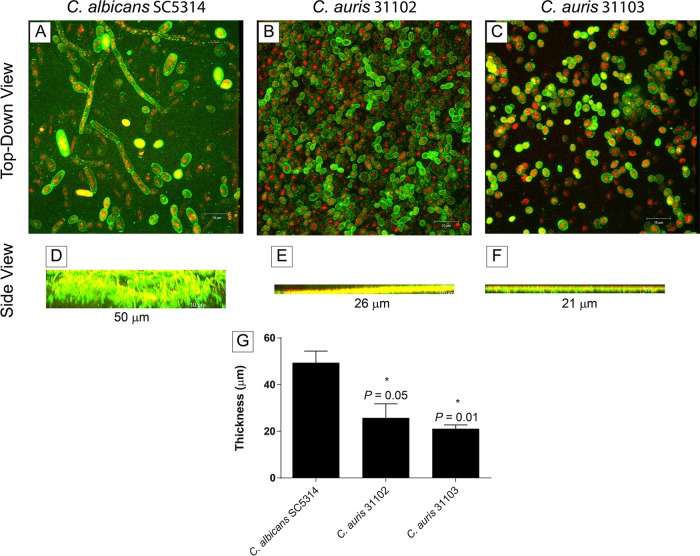
Formation of biofilms by C. albicans and C. auris strains. Confocal scanning laser micrographs show top-down three-dimensional views (A to C) and side views (D to F) of biofilms formed by C. albicans (A, D), C. auris MRL 31102 (B, E), and C. auris MRL 31103 (C, F). Magnifications, ×100. (G) Thickness of biofilms formed by the tested isolates. *, P value compared to the thickness of C. albicans biofilms. A P value of <0.05 was considered significant. All experiments were done in triplicate, and data represent means ± SDs. C. albicans SC5314 showed a highly heterogeneous architecture of biofilms with yeast cells and hyphae embedded within the extracellular matrix, while C. auris biofilms had minimal extracellular matrix and were significantly thinner than C. albicans biofilms.